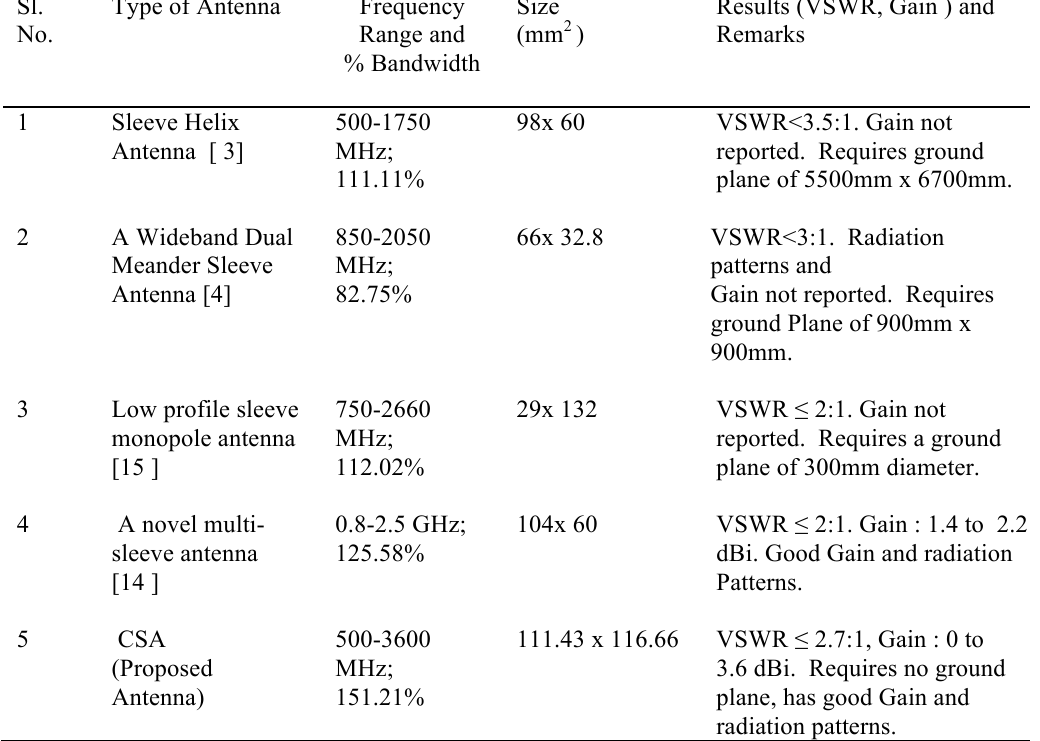
Table 2: Comparison of Results of Canonical Sleeve Antenna (CSA) with Published